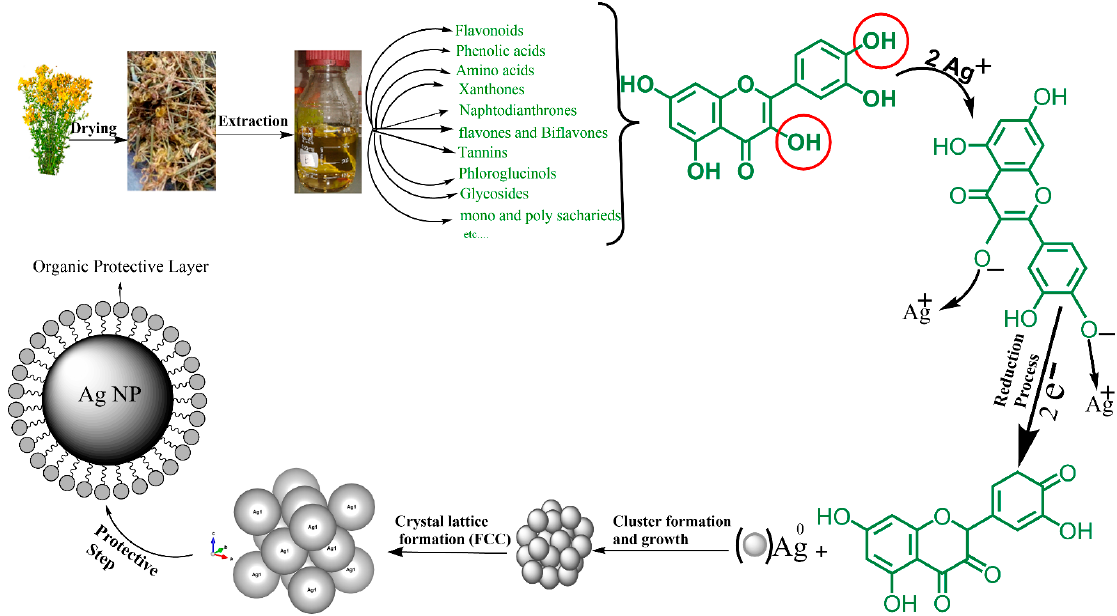
Figure 13. Scheme represents the proposed mechanism of green synthesis of AgNPs from Hypericum perforatum L. (quercetin was used as an example, because many of the phytochemicals or secondary metabolites present in this plant extract have a chemical structure similar to the chemical structure of quercetin in terms of the presence of hydroxyl groups associated with aromatic rings). These organic compounds reduce silver ions to silver metal, and when small clusters form and grow, the organic compounds are placed on the lattice planes to force them to grow in specific directions in order to obtain a certain crystal lattice (face centered cubic fcc in our case). At the same time, they prevent the aggregation of the nanoparticles and promote the production of smaller